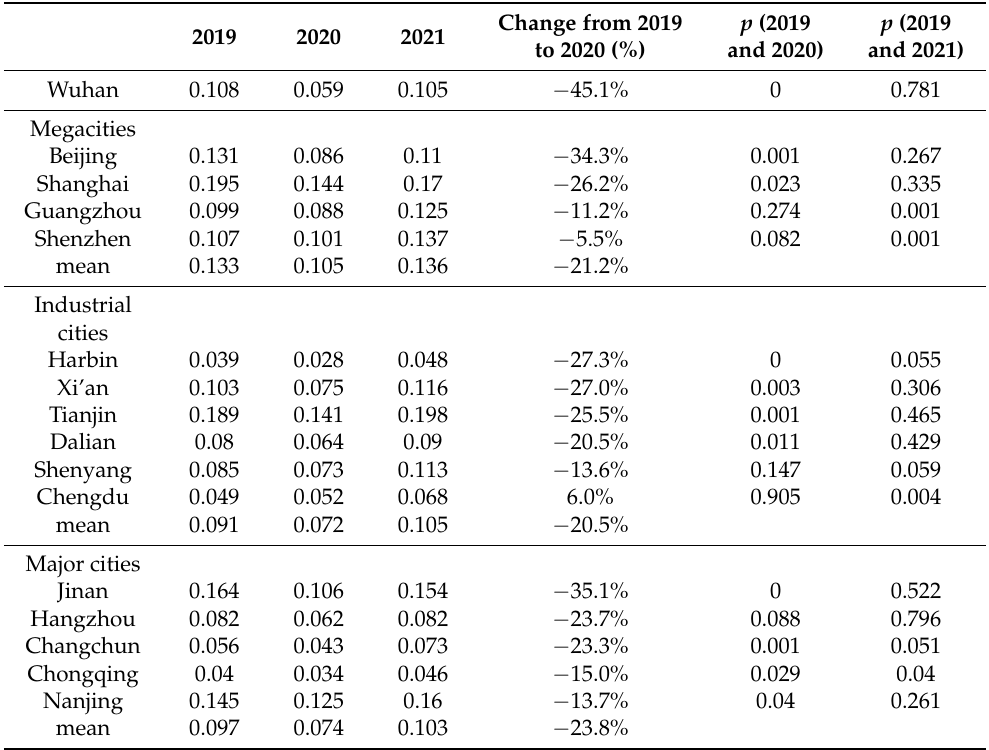
Table 3. Summary of NO 2 concentration amount (mmol/m 2 ), temporal changes, and non-parametric Wilcoxon test results among different